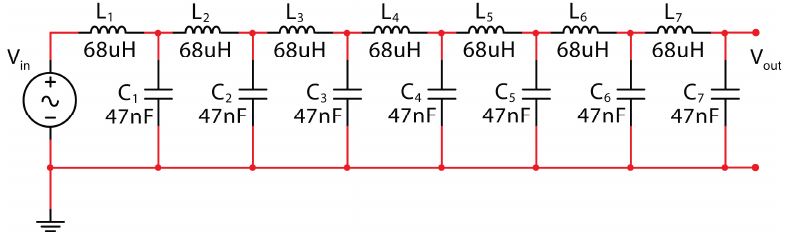
Figure 6. The seven-cell L.N. used as the reference L.N. in the work